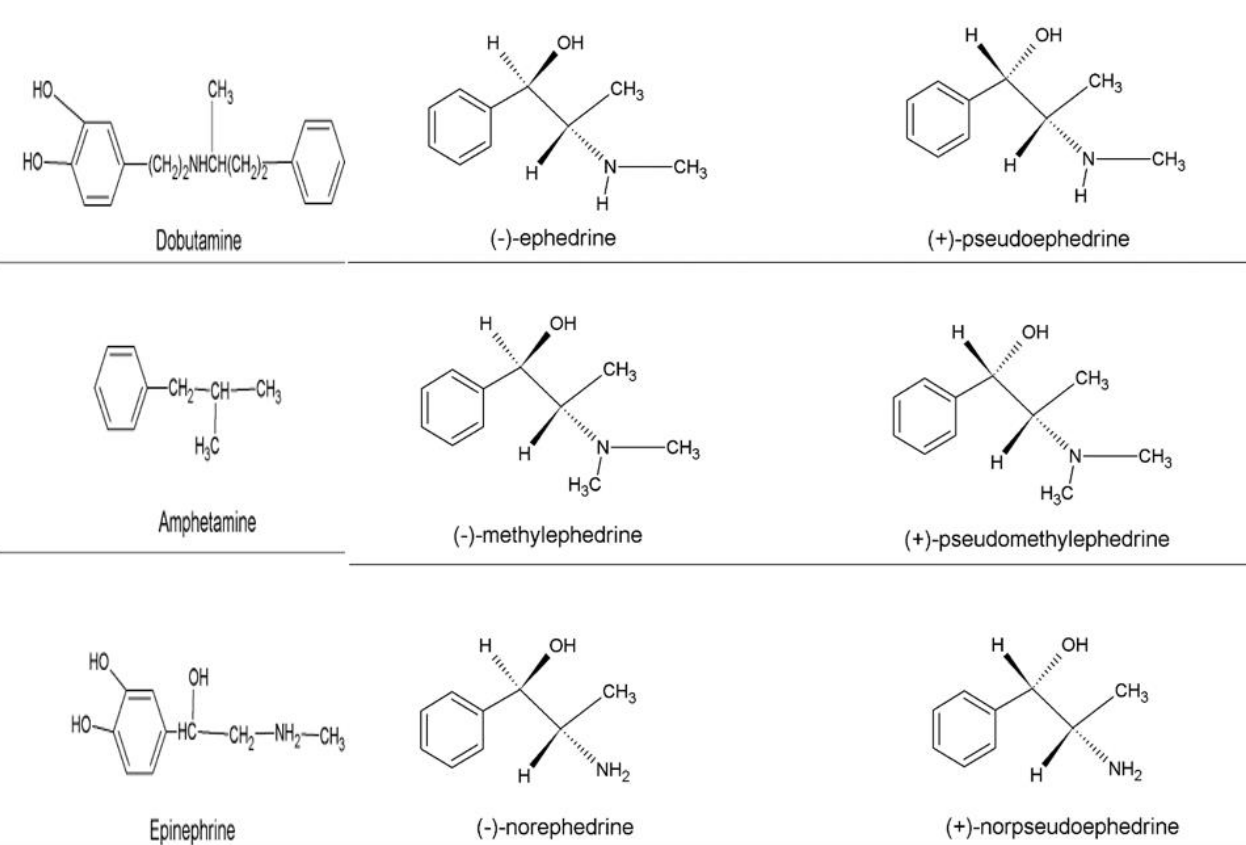
FIGURE 1 - Reported medicinally important phytochemicals extracted from different species of